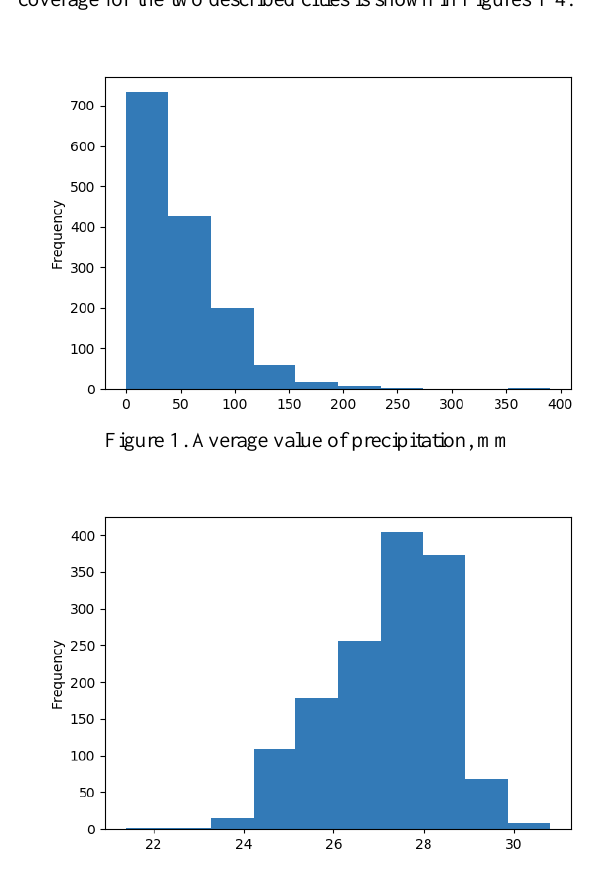
Figure 2. Average temperature, Celsius